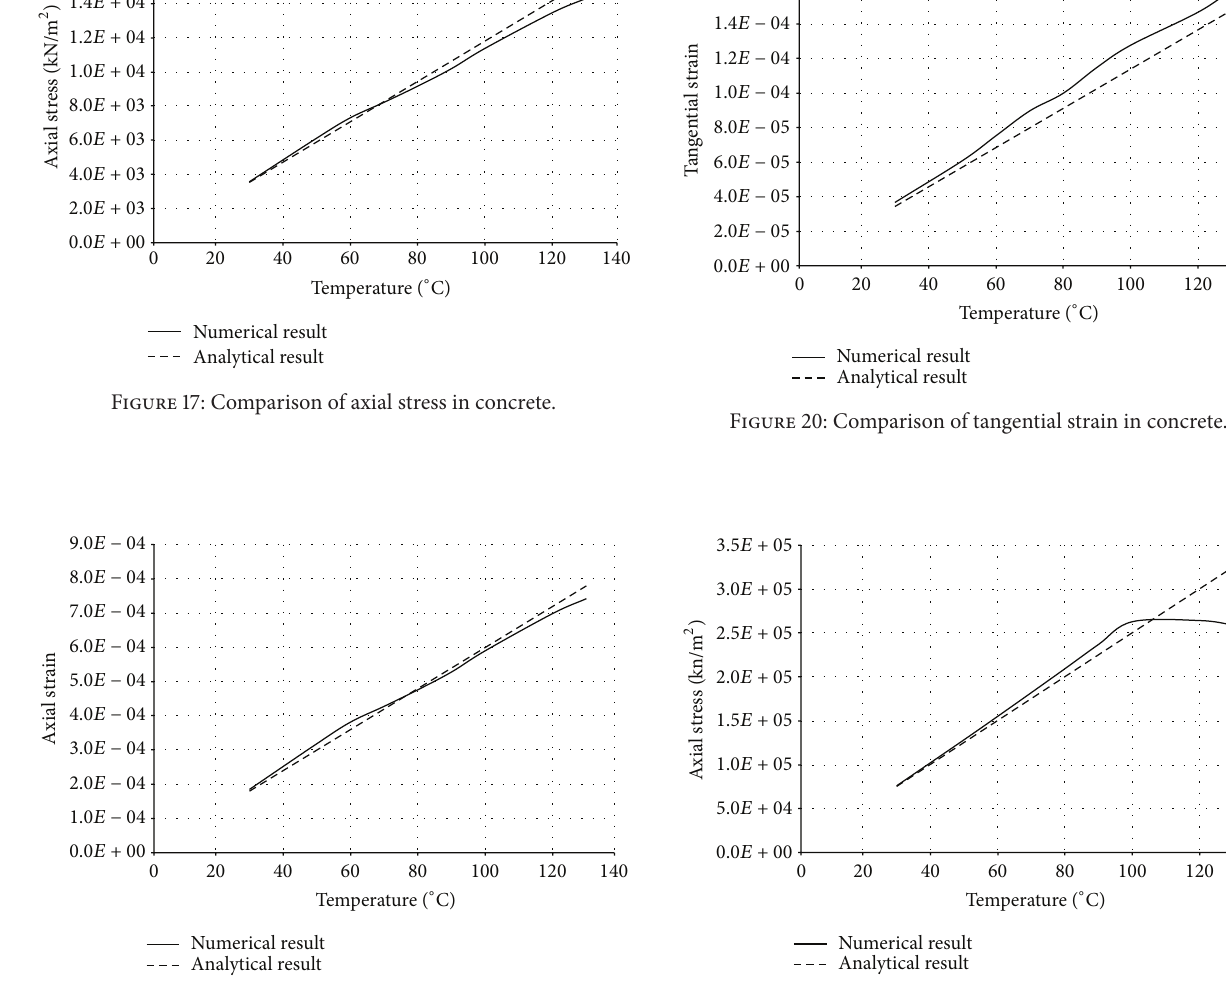
Figure 18: Comparison of axial strain in concrete.